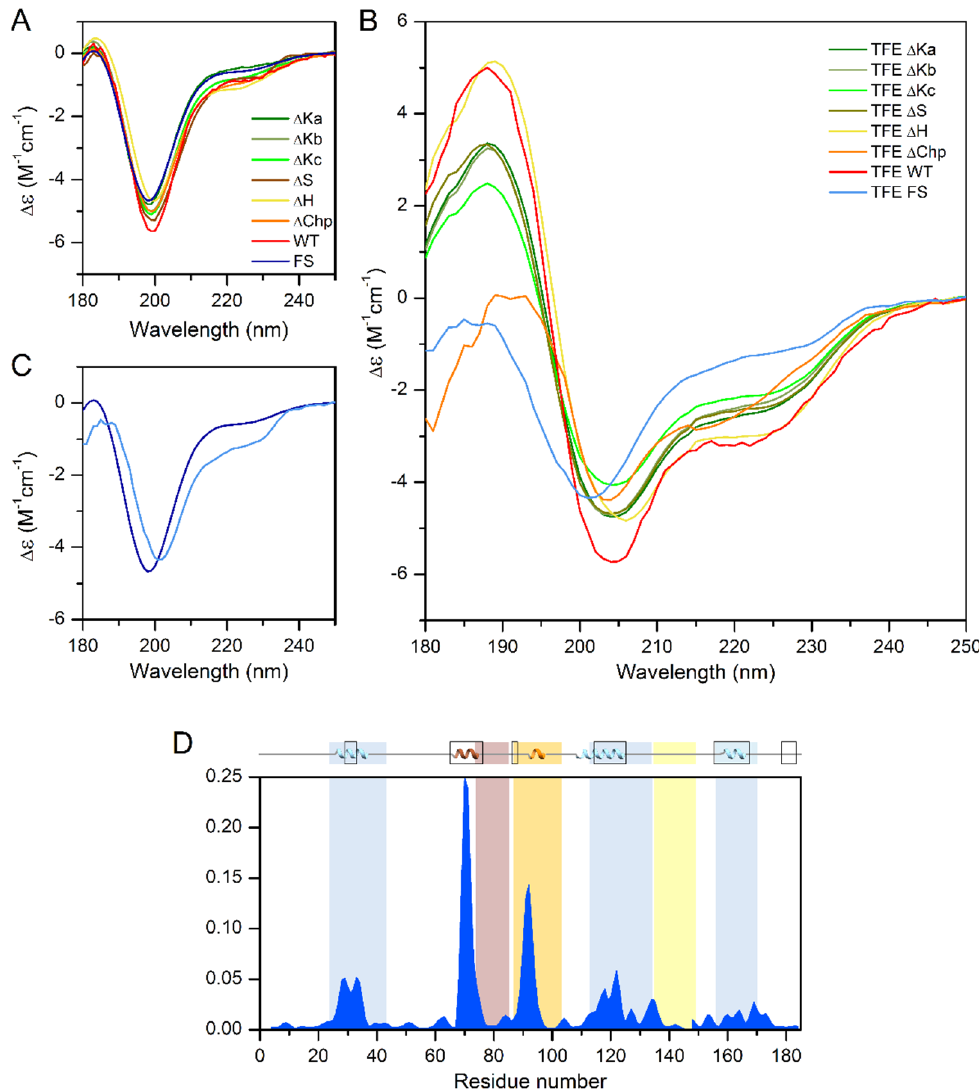
Figure 4. CD measurements of single deletion mutants and Full-Scr construct of ERD14 with TFE induced secondary structure changes. ( A ) Circular dichroism spectra of the ∆ Ka-, ∆ Kb-, ∆ Kc-, ∆ S-, ∆ H-, ∆ Chp-, and Full-Scr (FS) constructs of ERD14, recorded in 10 mM Na-phosphate buffer (pH 7.4), indicating similar, mainly disordered, structures, which is demonstrated by a characteristic minimum below 200 nm and low amplitude around 220 nm. ( B ) CD spectra of the different constructs of ERD14 recorded in Na-phosphate buffer containing 30% TFE. There are significant differences in the extent of the induced secondary structure, as shown by the spectral differences between the variants. ( C ) Comparison of the CD spectra of the FS ERD14 variant in native (dark blue) and in 30% TFE containing (light blue) buffer, indicating minor effects of TFE on the structure of the variant with scrambled sequence. ( D ) The degrees of formation of α -helices (blue areas) obtained with the δ 2D method [17] using Nuclear Magnetic Resonance Chemical shifts mapped to the WT ERD14 sequence, and its graphical representation inserted above the diagram shows good accordance with the in-silico estimated α -helix content [20] (boxes at the top).